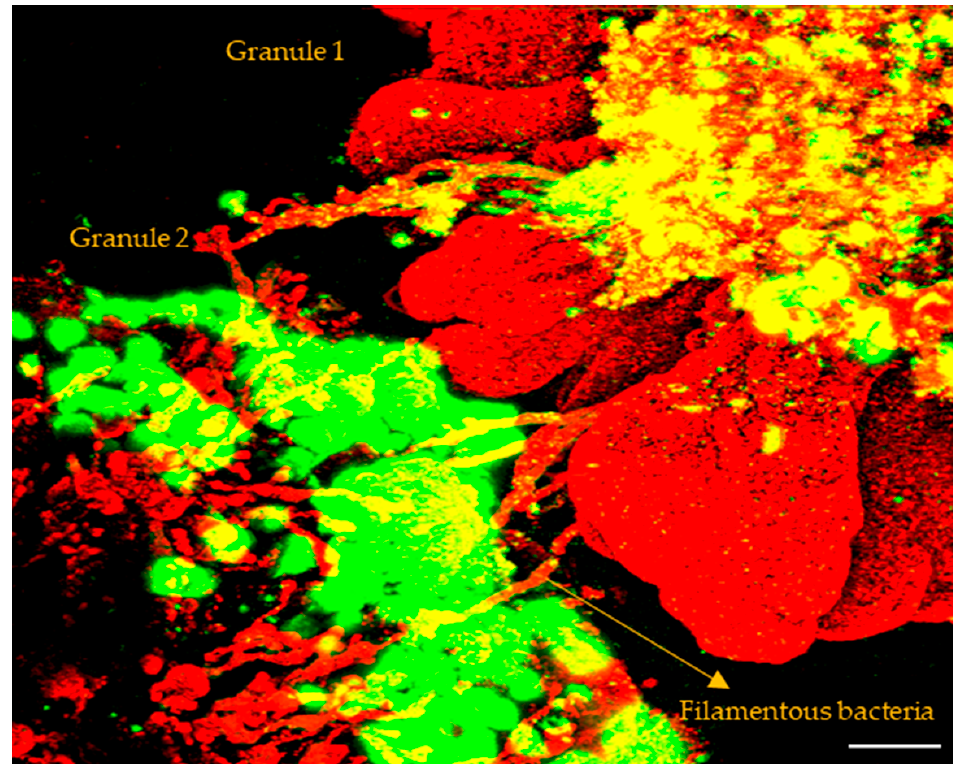
Figure 3. Two tiny bio-particles cohered by bridges of filaments and adhesion of EPS. Bacteria (red) and EPS (green). Scale bar = 50 μ m.